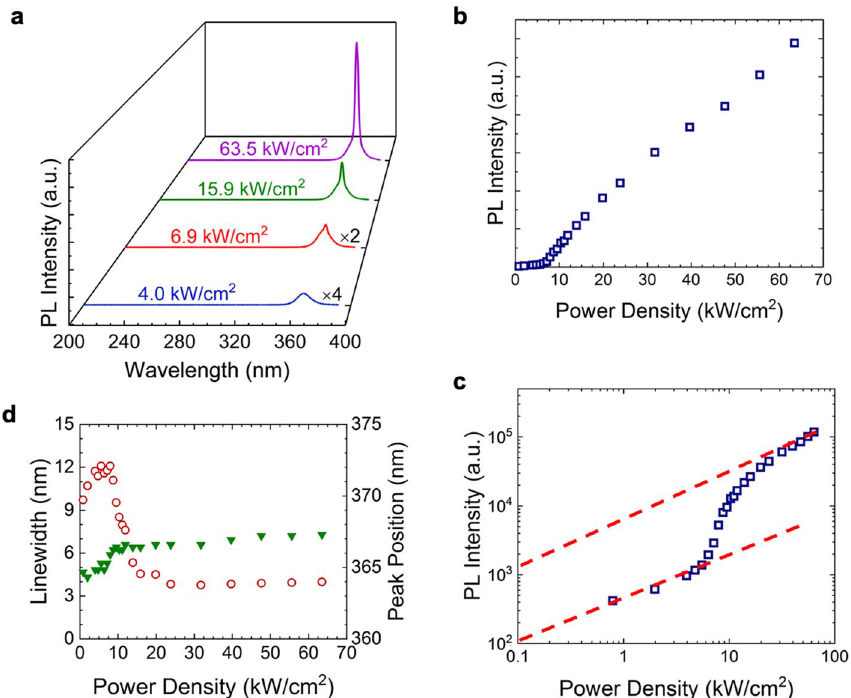
Figure 3. (Clockwise) ( a ) The light emission spectra of the NPC structure under different excitation powers. The light intensity versus the peak power density in a linear scale ( b ) and in a logarithmic scale ( c ). ( d ) Linewidth (open symbols) and the light emission peak position (filled symbols) versus the peak power density. Dash lines are a guide for